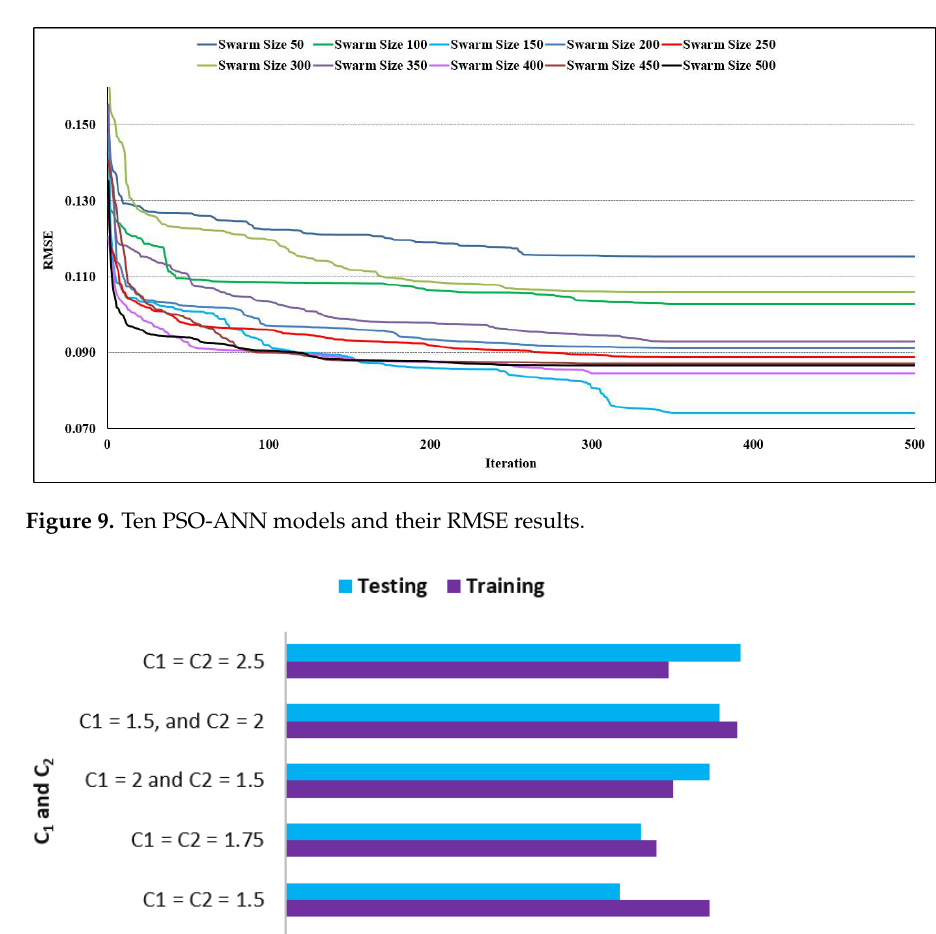
Figure 11. Results of w in PSO-ANN models. The procedures used by the ICA-ANN approach to model the bearing capacity of the SCFST columns are discussed herein. As previously stated, three factors, namely, N decade , N imp, and N country have a substantial impact on the performance capability of the ICA-ANN. As a result, designing these parameters and acquiring the optimal parameters values us- ing various PIs is necessary to accomplish the desired results. The first PI was carried out to pick N decade , and N country at the same time. Towards to the end, the first PI was structured